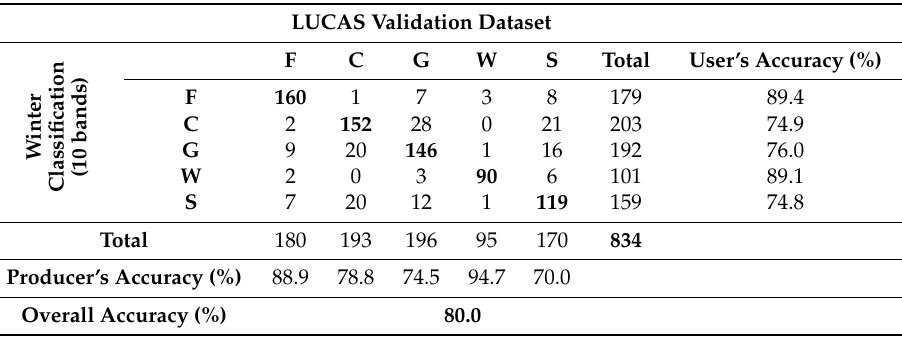
Table 4. The three-season confusion matrixes with 10 spectral bands (B2, B3, B4, B5, B6, B7, B8, B8a, B11, and B12). ( a ) Winter classification; ( b ) spring classification; ( c ) summer classification. The reference data used here were the LUCAS validation dataset with 834 points. The summer classification yielded the best OA with 91.4%, followed by the spring classification (85.5%) and winter classification